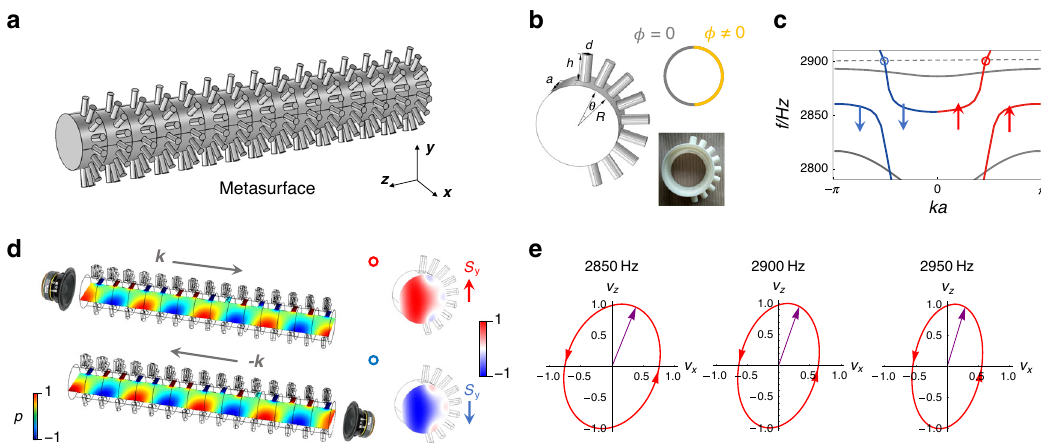
Fig. 2 Spin angular momentum in acoustic waveguide with metasurfaces. a The side bar structures are exploited to achieve the acoustic metasurface with arbitrary re fl ection phase ϕ ≠ 0. b The unit cell of metasurface waveguide. Here, we choose the geometrical parameters as: a = R = 4 cm, d = 1 cm, h = 2.5 cm, θ = 20°, to achieve ϕ = π . c The z -direction dispersion relationship is calculated and the sign of tranverse SAM S y in eigenmodes have been shown by the red and blue colors. d The excited waveguide modes with different propagation directions will carry opposite SAM texture at 2.9 kHz. e The elliptically polarized velocity fi eld simulated at the center point of the metasurface waveguide. The plotted velocity fi eld is normalized by the amplitude of v fi eld and its time evolution (More cases can be found in z . The purple arrow and the arrowed red circle denotes the polarization of the velocity Supplementary Note